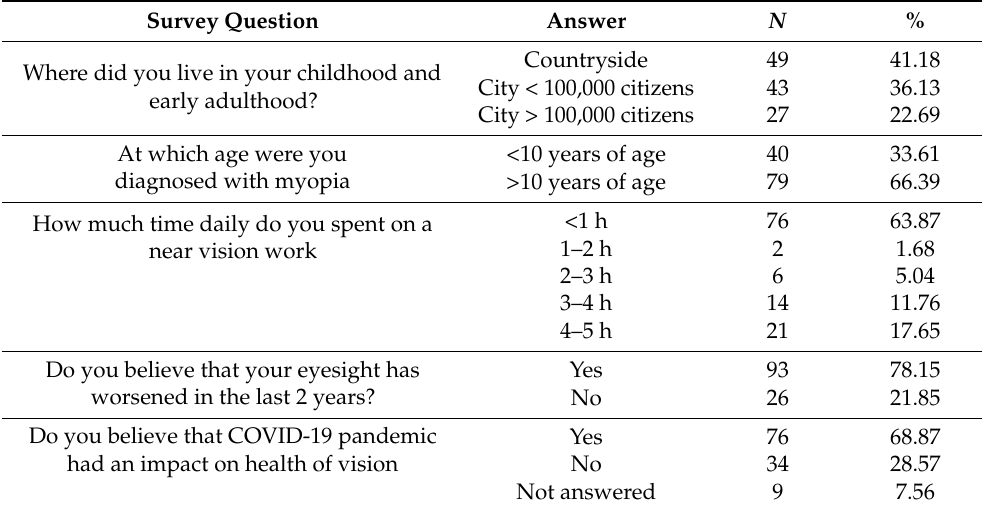
Table 2. Survey answers in the myopic